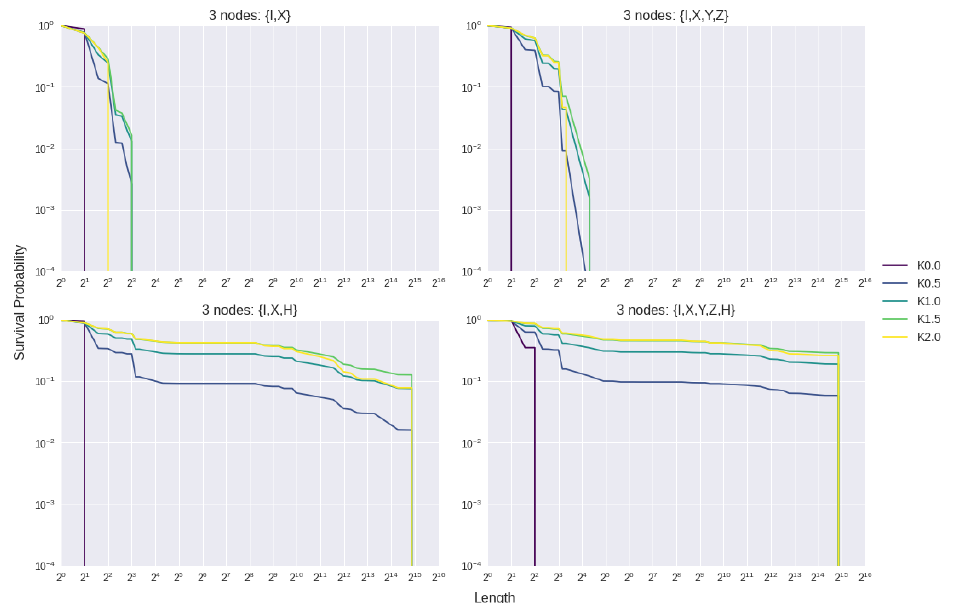
Figure 3. Survival probability for different connectivity values of a network with 3 nodes. The survival probability is computed from 20,000 realizations. The survival probability for reversible Boolean networks (RevBNs) and QBNs for different network sizes can be consulted in Figures A1 and